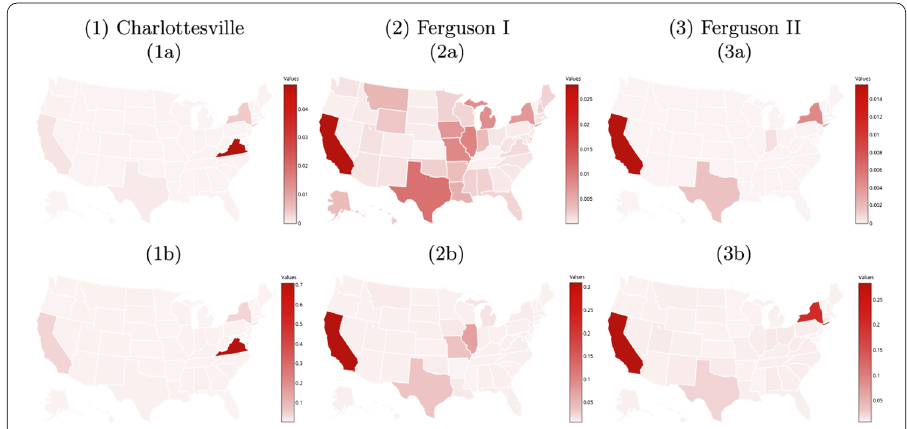
Figure 9 Exploration of global contribution and hub effect. ( a ) Mean absolute values of inter-region input weights across states. ( b ) Attention weights of spatial attention for predicting protests in TX (1b), WA (2b),